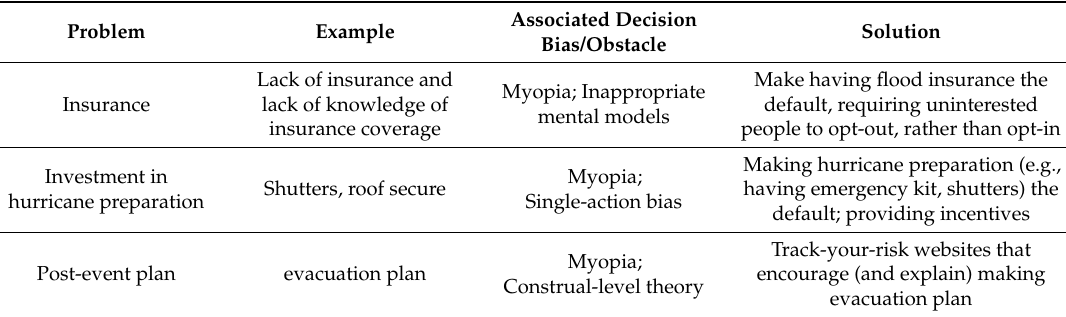
Table 2. Decision biases and solutions during pre-season preparation